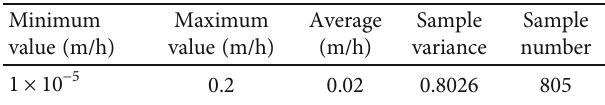
Table 1: Statistics of permeability coe ffi cient of Mesozoic Cretaceous in western